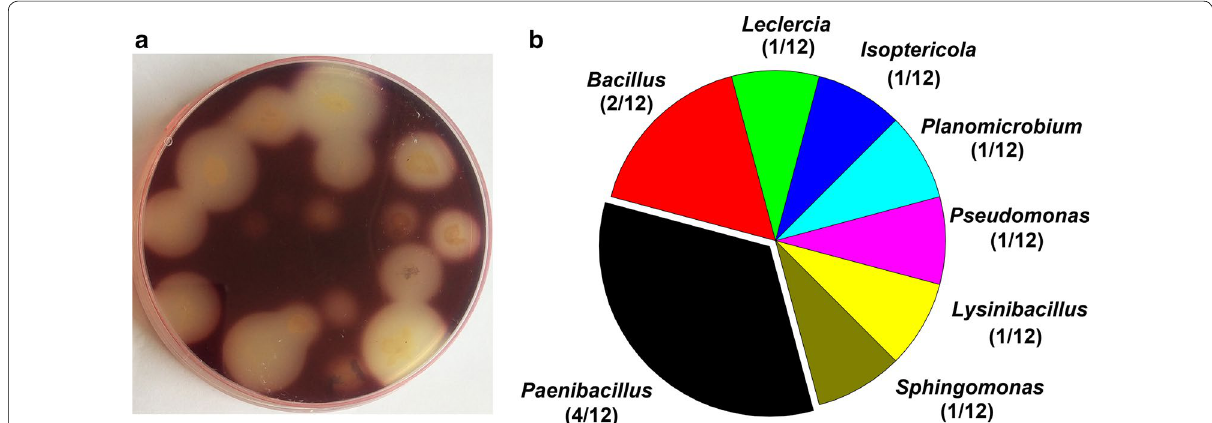
Fig. 1 Isolation and identification of alginate lyase-excreting strains. a Gram’s iodine staining, showing the distinct zones of clearance of the algi-